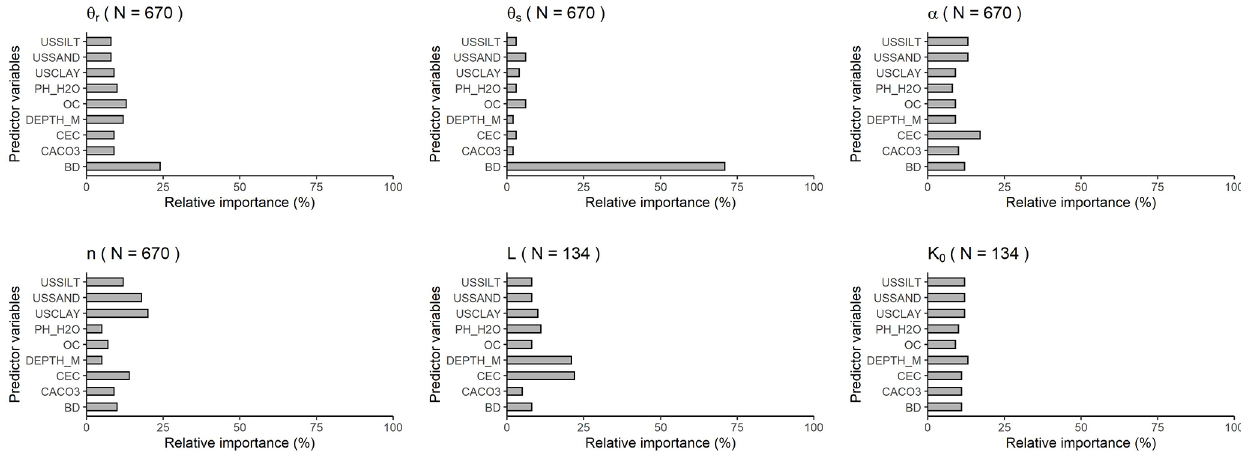
Figure 7. Relative variable importance computed with the random forest algorithm for the prediction of parameters of the van Genuchten and Mualem–van Genuchten models based on PTF32. θ r : residual water content (cm 3 cm − 3 ); θ s : saturated water content (cm 3 cm − 3 ); α (cm − 1 ), n (–): shape parameters; K 0 : the hydraulic conductivity acting as a matching point at saturation(cmd − 1 ); L : shape parameter related to